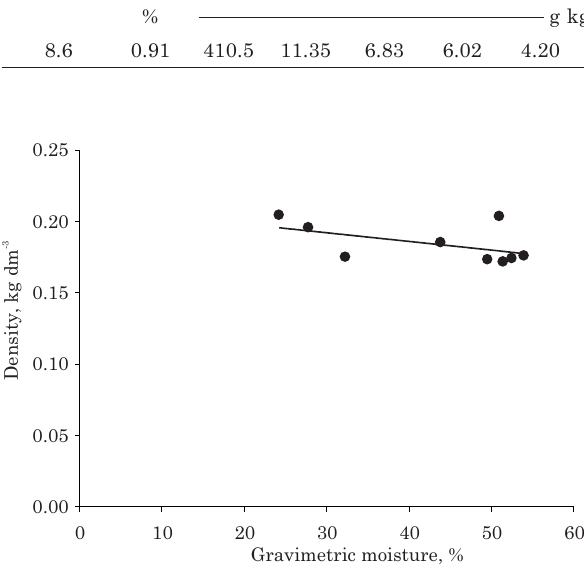
Figure 1. Density of rice husk ash (dry mass at 110 o C) according to the moisture content. ns: non- significant by the F test at